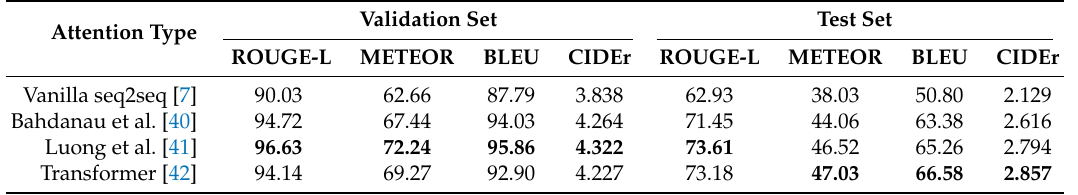
Table 6. Performance comparison of sign language translation on different types of attention mechanisms. Attention